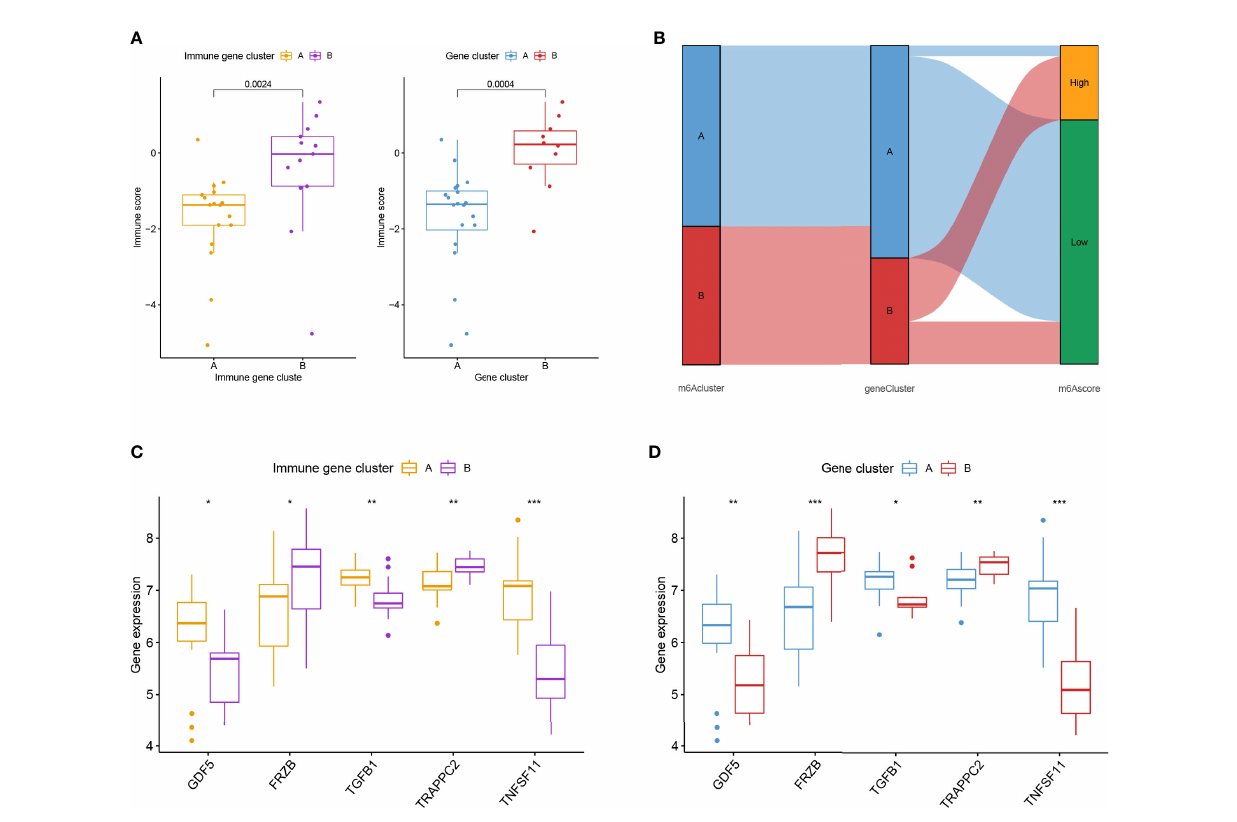
FIGURE 5 External validation for the two immune subtypes in GSE82107. (A) Boxplot showed the difference in immune score in the immune gene cluster and gene cluster in GSE82107. (B) The Sankey diagram showed the distribution of patients in different clusters. (C, D) Expression difference of fi ve osteoarthritis-related genes in the immune gene cluster (C) and gene cluster (D) . * means P < 0.05, ** means P < 0.01, *** means P <